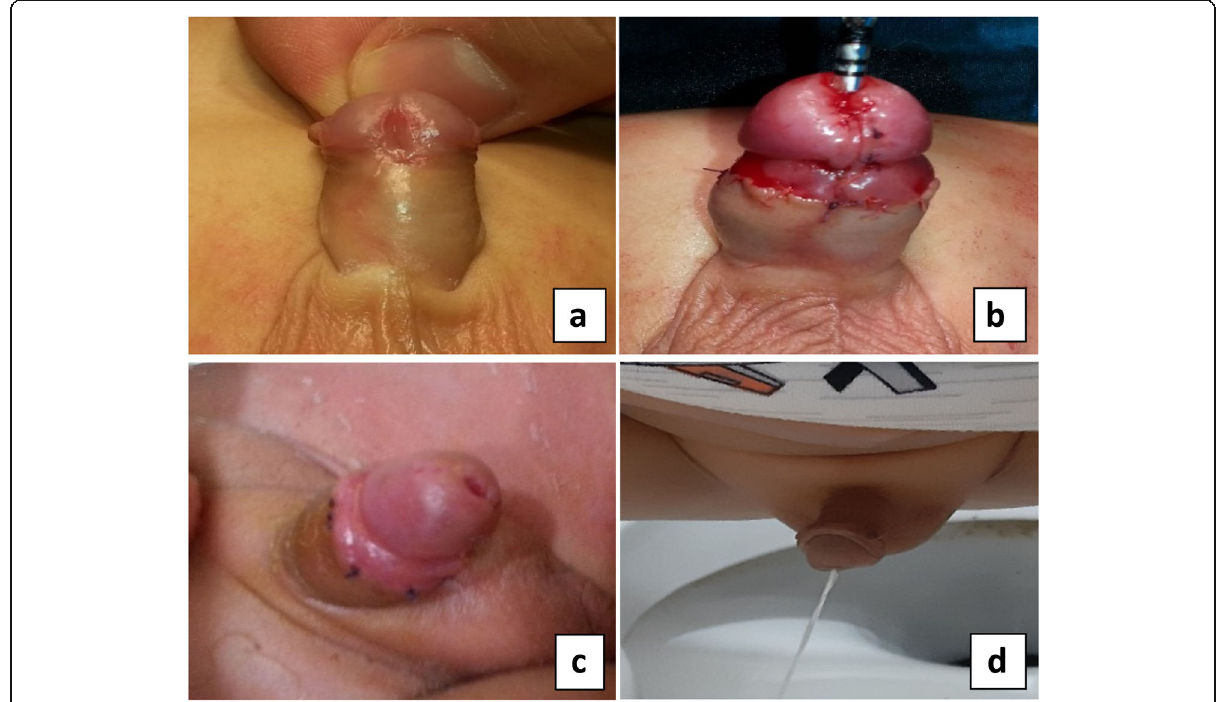
Fig. 2 a Uncircumcised subcoronal hypospadias (preoperative). b at the end of surgery. c three weeks postoperatively. d urinary stream